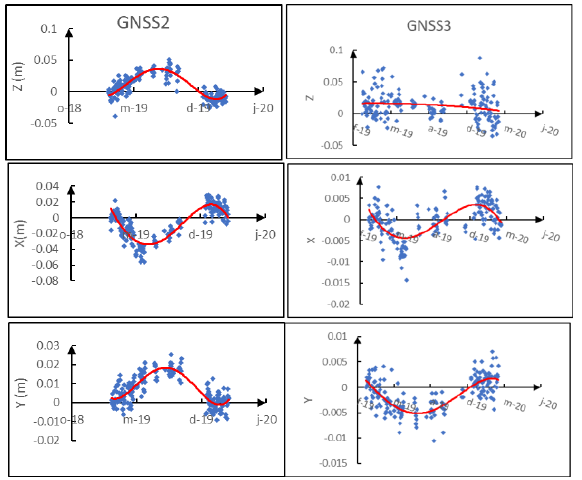
Figure 9. Seasonal displacements on north pylon (GNSS2) and mid-span (GNSS3) Figure 11. Detected PS on mean amplitude background in SAR geometry (Left). PSC and PS after phase stability analysis (right) Corrected 3D position of PS (longitude, latitude, height) (Figure 12) shows that the detected PS are located on the ground level underneath the bridge. And giving that the bridge is not included in DEM used for topographic phase removal, the residual DEM error is expected to be about a hundred of meters on the bridge. Even though, it does not exceed 40m on the entire studied region.